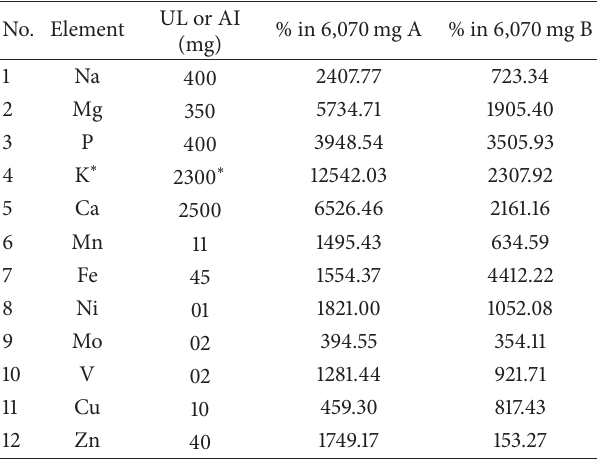
Table 2: Mean quantities of selected elements in 6,070 mg ∗∗ of samples expressed as percentages of UL or AI [15,